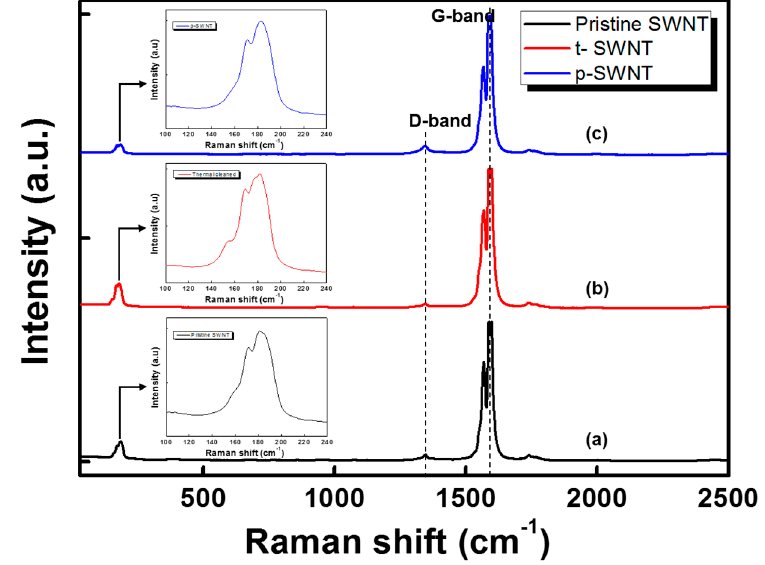
Figure 6. Raman spectra for the modified SWNTs: ( a ) pristine SWNT; ( b ) t-SWNT; and ( c ) p-SWNT. Table 2. Radial Breathing Mode (RBM) peaks of the modified SWNTs.